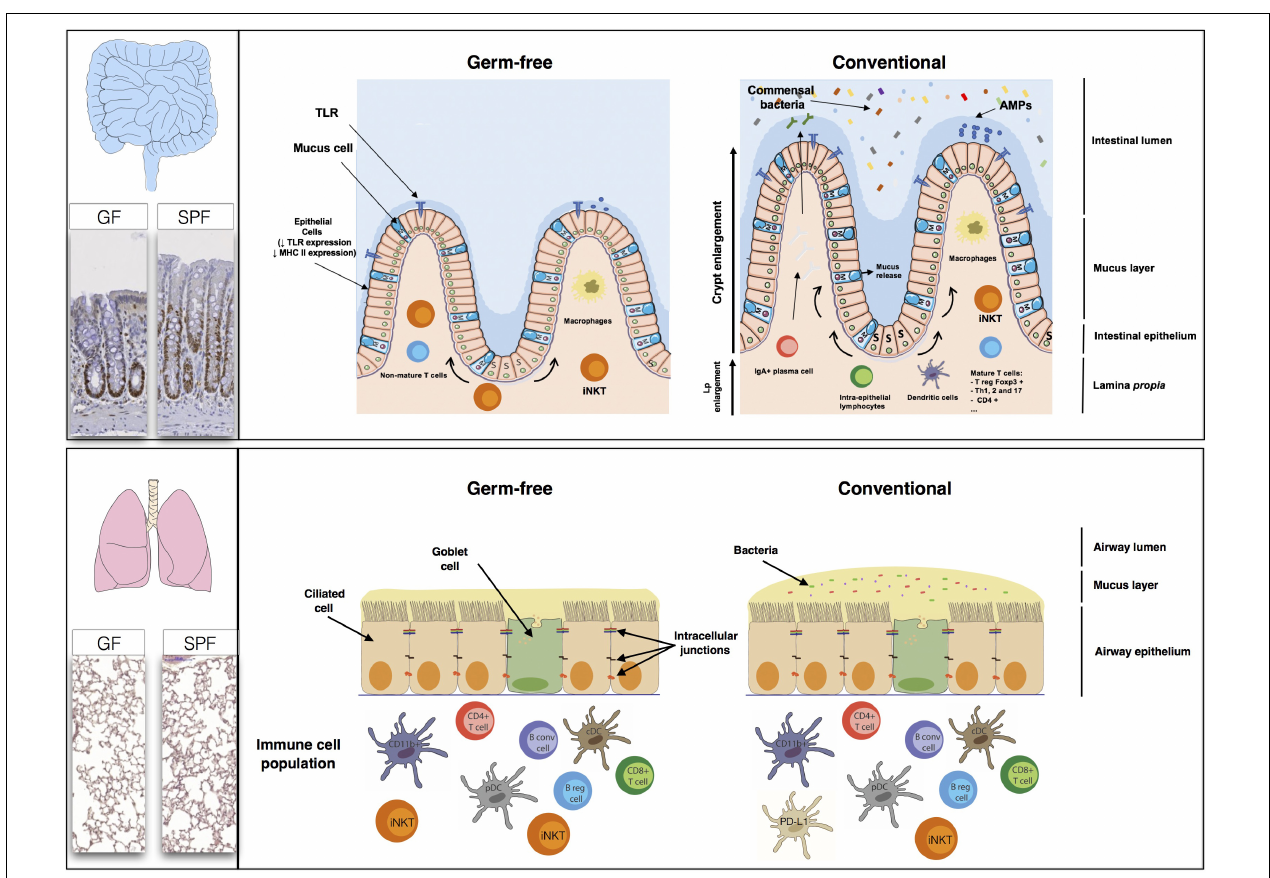
FIGURE 3 | The high rate of renewal of the intestinal epithelium and the diversity of the populations of cells in the intestinal mucosa, comprising immune, absorptive and secretory cells, create a large, flexible arsenal of innate, and acquired defenses against a dense microbiota. Studies in germ-free (GF) mice have shown that normal gastrointestinal tract development is dependent on the presence of a commensal microbiota. The epithelial cell monolayer is linked and maintained by the apical junctions, consisting of adherens, and tight junctions (Miyoshi and Takai, 2005). The regulation of apical junctions is crucial, to prevent the translocation of bacteria, or molecules through the cell monolayer. The lungs appear to be less affected by the absence of a microbiota than the gut. The levels of B cells, T cells, conventional dendritic cells (cDC), and plasmacytoid dendritic (pDC) cells are similar in GF mice and SPF mice. The only major differences between GF and SPF mice are that PD-L1 expression is stronger in SPF mice, whereas GF mice have higher iNKT levels (both in the lungs and the gut) than SPF